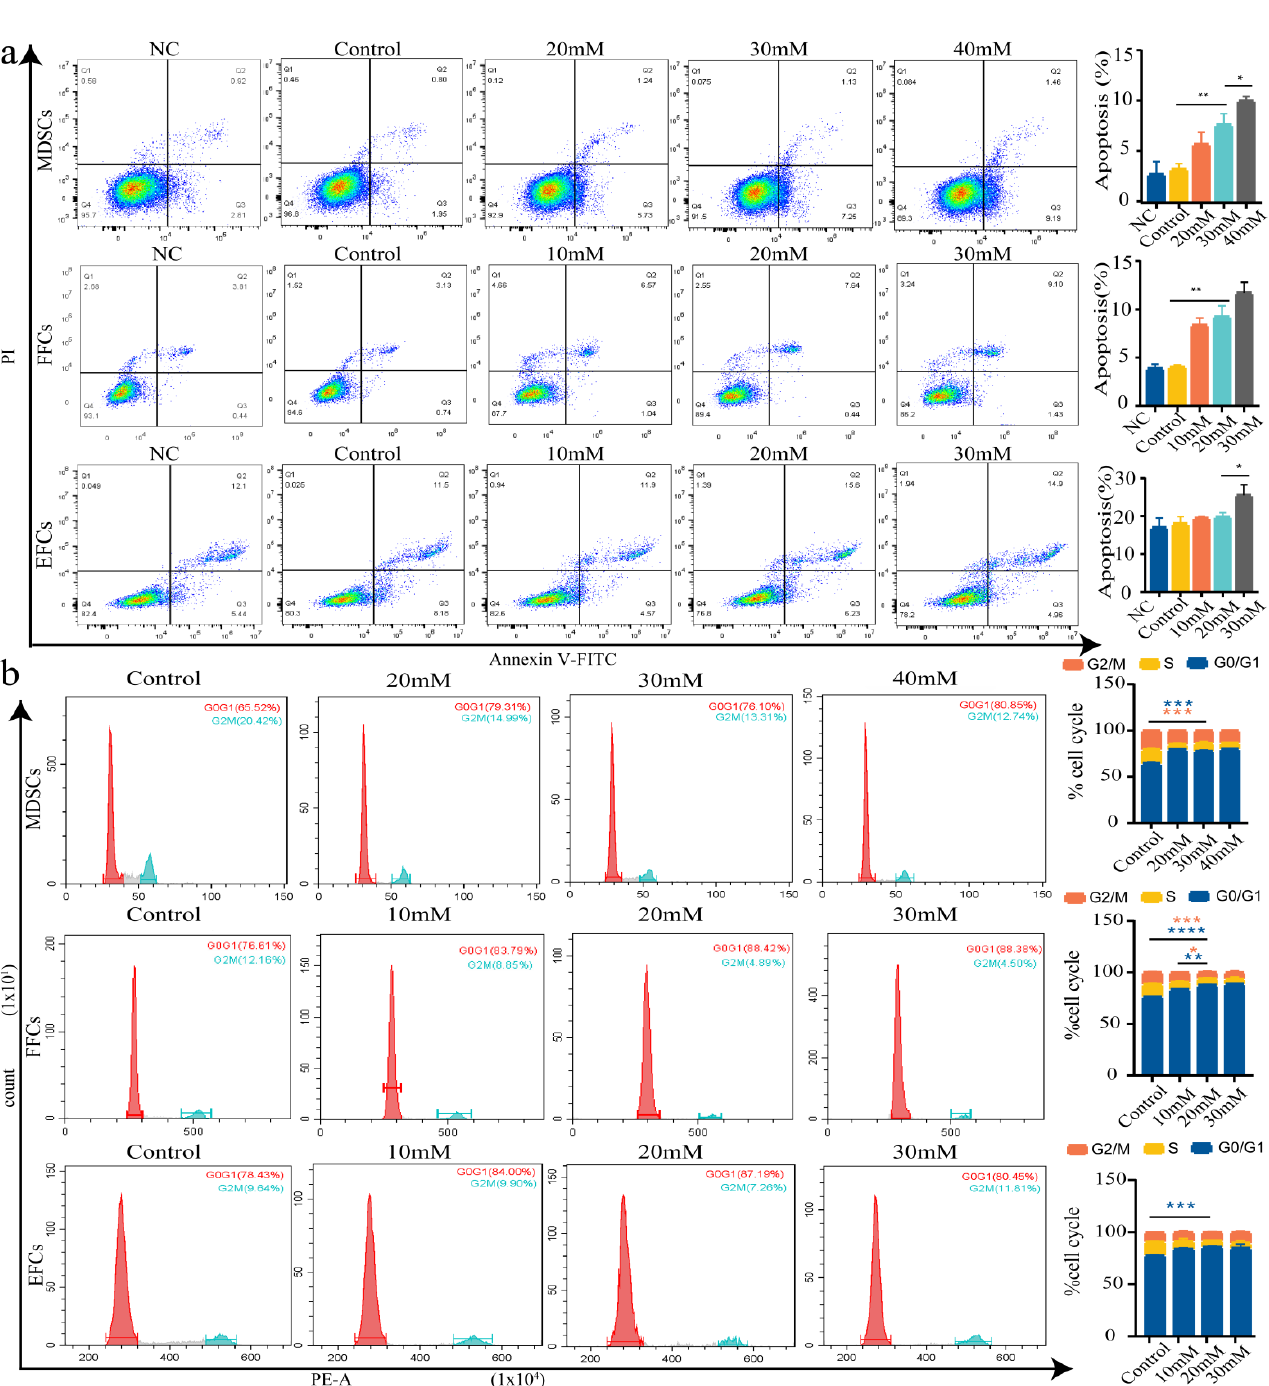
Figure 3. Apoptosis and cell cycle of somatic cells treated with different concentrations of NaCr. ( a ) Apoptosis assessment of MDSCs, FFCs, and EFCs treated with 10 mM, 20 mM, 30 mM, and 40 mM NaCr for 24 h by flow cytometry. The histogram shows the apoptosis statistics. Control group: cells that received no treatment. Negative control group (NC): cells that were treated with normal saline. ( b ) A cell cycle analysis was used to detect the cell cycle distribution after the NaCr treatments. Blue asterisks represent significant differences in the G0/G1 phase among the different groups. Pink asterisks indicate significant differences in the G2/M phase among the different groups. Control group: cells that received no treatment. * p < 0.05, ** p < 0.01, *** p < 0.001, **** p < 0.0001; no asterisk indicates no significant difference.